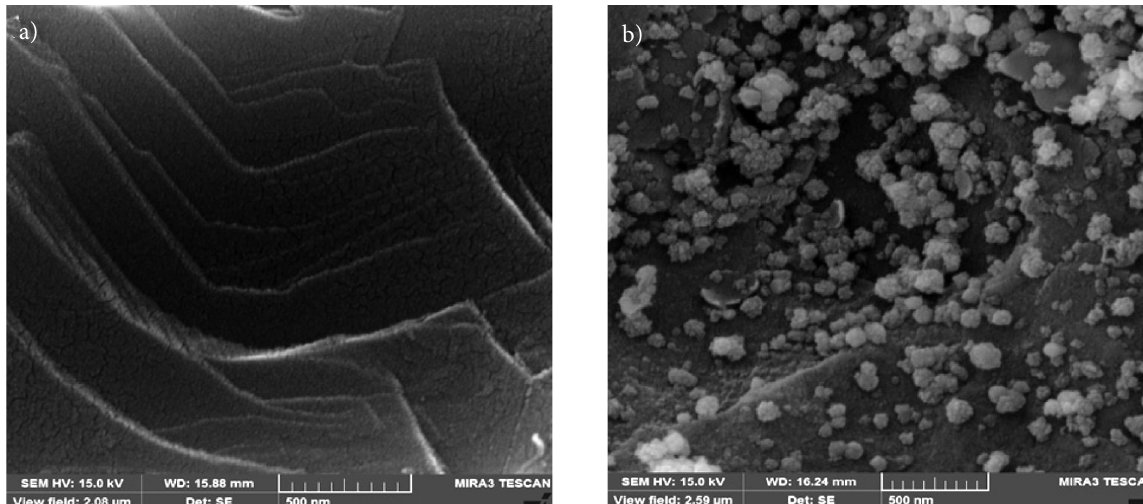
Figure 3. SEM images of (a) pure GO and (b) Ag/CuFe 2 O 4 /rGO